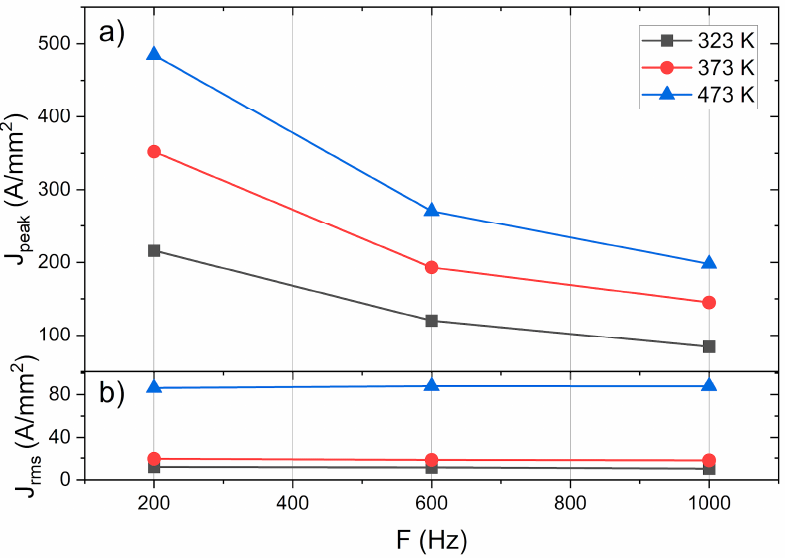
Figure 6. ( a ) Peak current density measured prior to tension and ( b ) its root mean square value. Global temperature is different from local temperature, which occurs on a microscale.